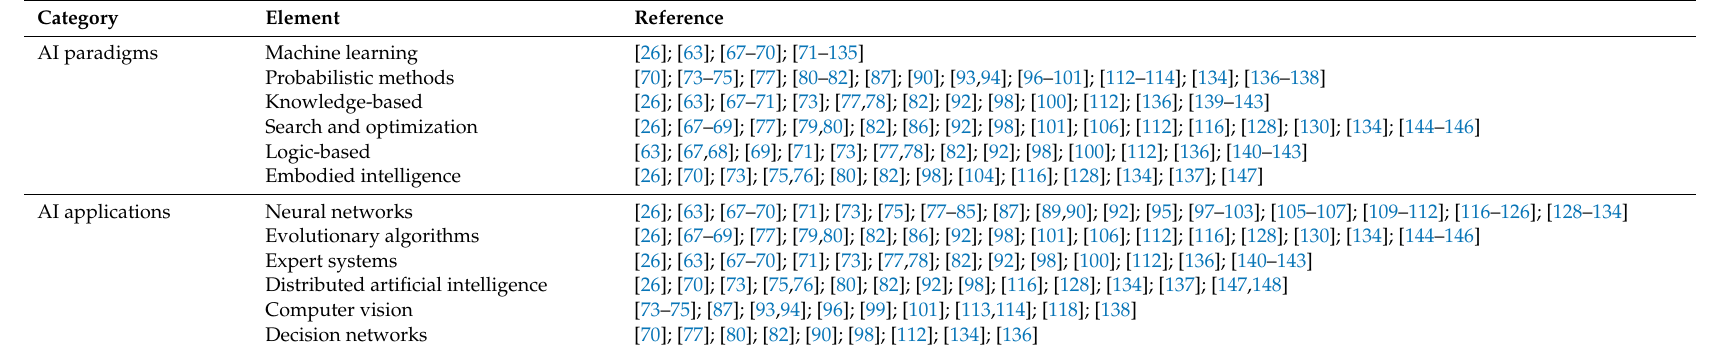
Table 2. The common AI paradigms and applications identified in the